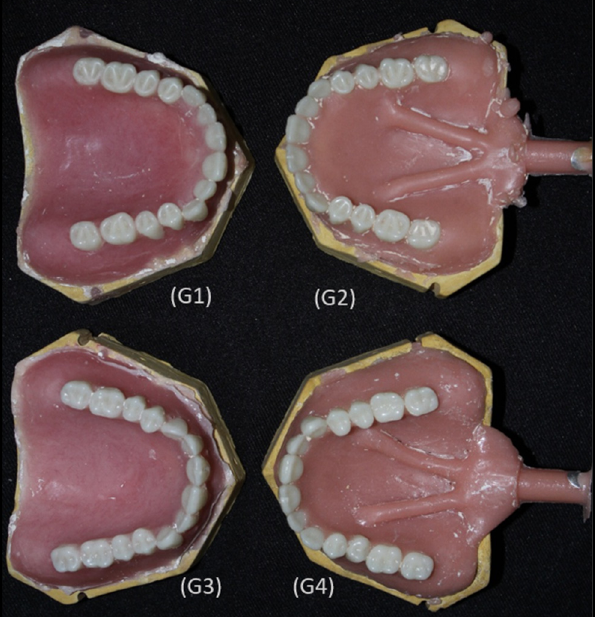
Figure 3. Dentures after processing: G1: conventional compression molding technique with non- anatomical tooth form; G2: injection molding technique with non-anatomical tooth form; G3: con- ventional compression molding technique with semi-anatomical tooth form, G4: injection molding technique with semi-anatomical tooth form.